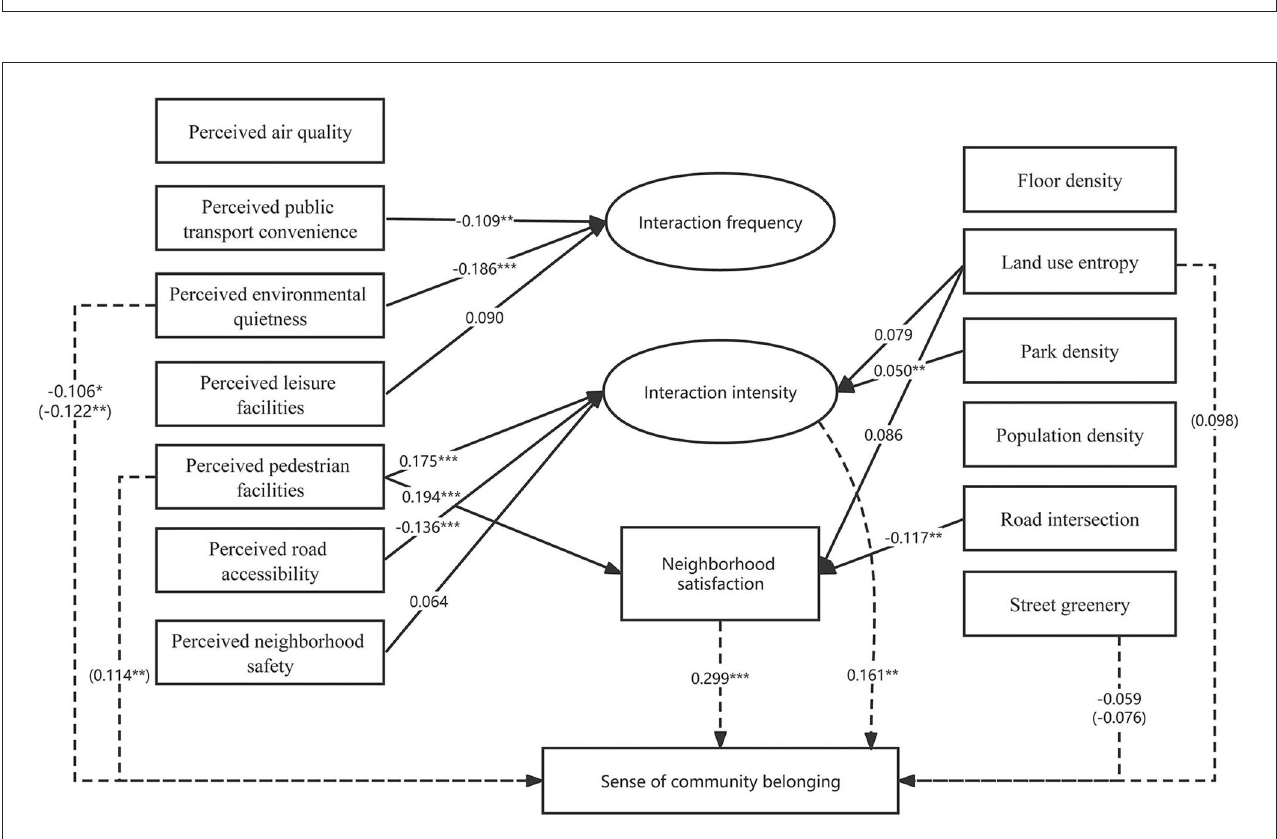
FIGURE5 SEM analysis of the relationship between the built environment and SCB (male) (*** p -value < 0.01, ** p -value < 0.05, * p -value <